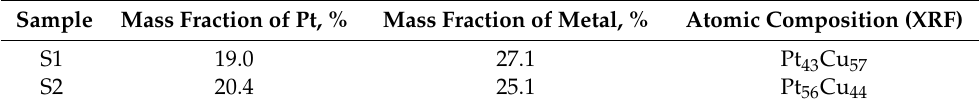
Table 1. The compositional characteristics of the PtCu/C catalysts.